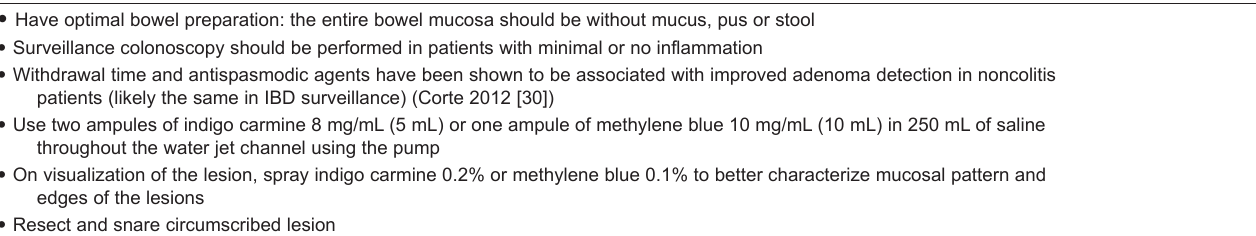
TAble 2 Optimization strategy of surveillance in inflammatory bowel disease